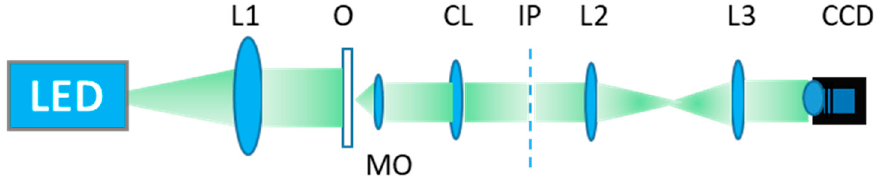
Figure 2. Schematic of the experimental setup for TIE; L1: Condenser lens, O: Object, MO: Micro- scopic objective lens, CL: Collimating lens, IP: Image plane, L2 and L3: 4f imaging relay system, CCD: Charge-coupled device.